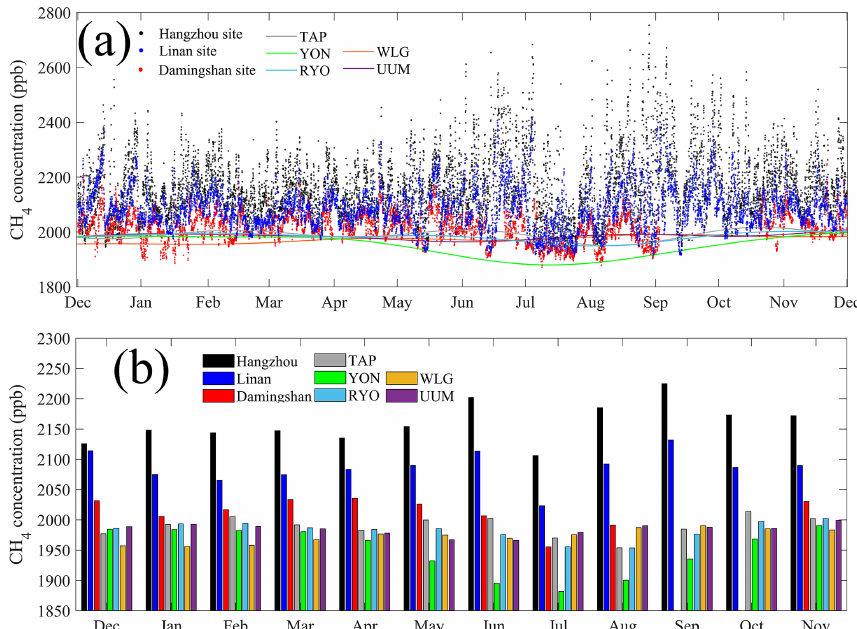
Figure 2. (a) Hourly CH 4 concentrations at three sites within Hangzhou – the Hangzhou site, Linan site and Damingshan site – and the CH 4 background based on the CCGCRV (a digital filtering and curve-fitting program developed by Carbon Cycle Group, NOAA, USA) regression method at five background sites – TAP, YON, RYO, WLG and UUM. (b) Monthly mean of CH 4 concentrations for the above eight sites. Note the CH 4 background is smoothed by using the CCGCRV fitting method on weekly or hourly observations, which can filter large fluctuations caused by sudden and unidentified